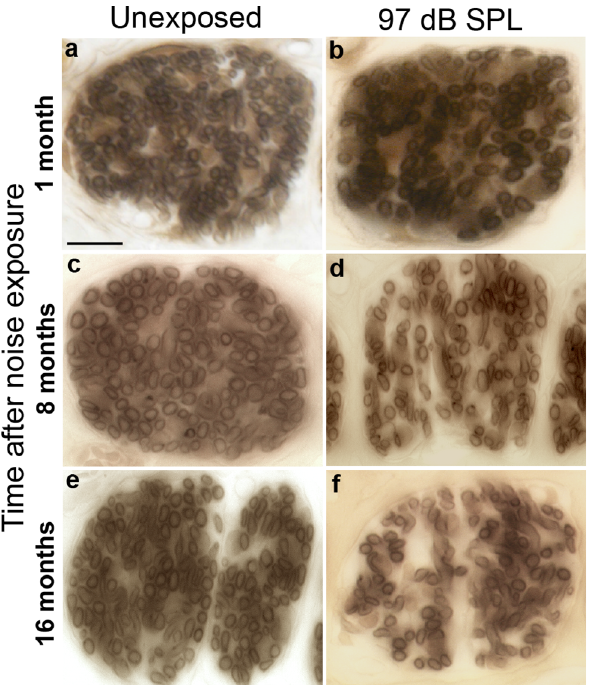
Fig 6. Cochlear-nerve peripheral axons can be counted in tangential sections through the osseous spiral lamina. Tangential cuts though the osseous spiral lamina in the ~32 kHz region of cochleae 1 month ( b ), 8 months ( d ) or 16 months ( f ) after exposure to neuropathic noise (97 dB SPL) demonstrate loss of peripheral axons compared to age-matched unexposed controls ( a , c , e ). These sections show fascicles of cochlear-nerve peripheral axons roughly midway between their cell bodies in the spiral ganglion and their peripheral terminals in the organ of Corti. Scale bar: 10 μ m ( a - f ).